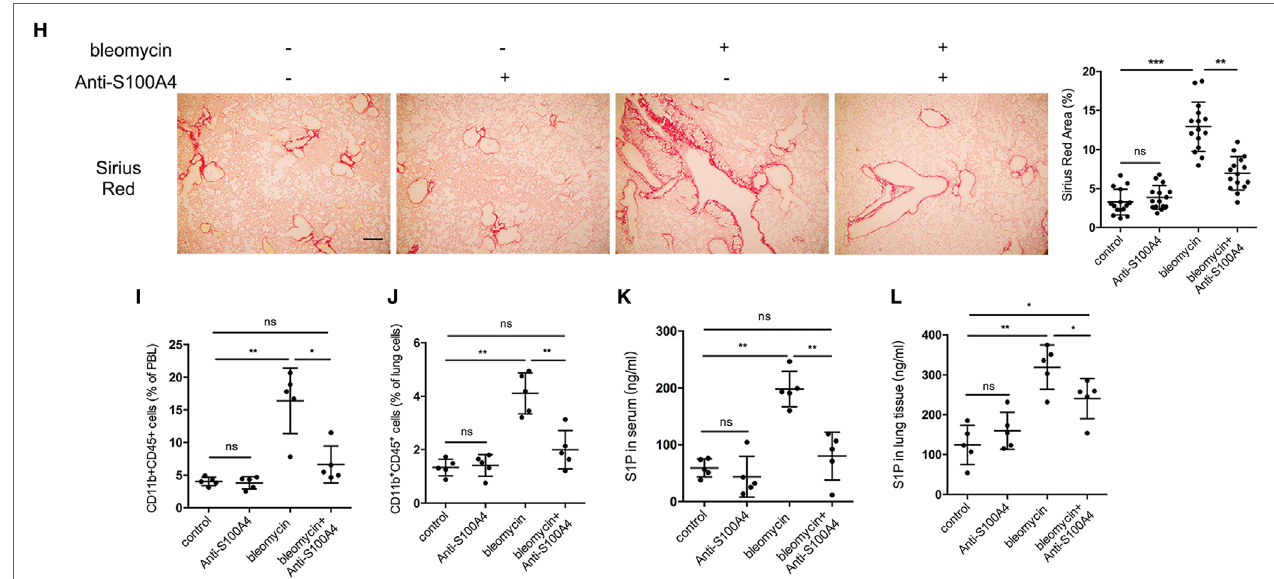
FigUre 5 | Block of extracellular S100A4 abrogates pulmonary fibrosis and the increased sphingosine-1-phosphate (S1P) in vivo . (a–D) WT and S100A4 − / − mice were treated once with or without bleomycin. Lung tissues were studied 14 days later. Three independent experiments with n = 5 mice per time point and experiment. (a) H&E staining for tissue integrity and immune-cell infiltration. (B) Sirius Red staining for collagen deposition. (c) α -SMA (red) stained by immunofluorescence. (a–c) Representative images, scale bar 100 µm. Mean ± SEM, *** p < 0.001, Mann–Whitney. (D) Protein levels of α -SMA were evaluated by western blot analysis as described for Figure 3c . Representative blots from two mice per group and mean ± SEM, * p < 0.05, Mann–Whitney. (e,F) S100A4 − / − mice received spleen-derived CD11b + cells (2 × 10 6 ) from S100A4 + / + GFP mice either positive or negative for S100A4 as sorted via the GFP reporter. Lung tissues were studied after 14 days. Three independent experiments with n = 5 mice per group and experiment. (e) H&E or Sirius Red staining for tissue integrity and immune-cell infiltration or collagen deposition. Representative images, scale bar 100 µm. Mean ± SEM, *** p < 0.001, by Mann–Whitney. (F) Protein levels of α -SMA were evaluated by western blot analysis as described for Figure 3c . Representative blots from two mice per group and mean ± SEM, * p < 0.05, Mann–Whitney. (g–l) WT mice were treated once with bleomycin. Starting at day 0, they received five repeated doses of anti-S100A4 (4 mg/kg) every third day. After 14 days, lung tissues and blood were studied. Three independent experiments with n = 5 mice per group and experiment. (g) H&E staining for tissue integrity and immune-cell infiltration. (h) Sirius Red staining for collagen deposition. Representative images, scale bar 100 µm. Mean ± SEM, ** p < 0.01 and *** p < 0.001, Kruskal–Wallis. (i) PBL or (J) suspended lung cells stained for CD11b and CD45 were assessed by flow cytometry. S1P concentrations in panel (K) serum or (l) lung tissue were detected by enzyme-linked immunosorbent assay. (i–l) Mean ± SEM, * p < 0.05 and ** p < 0.01,